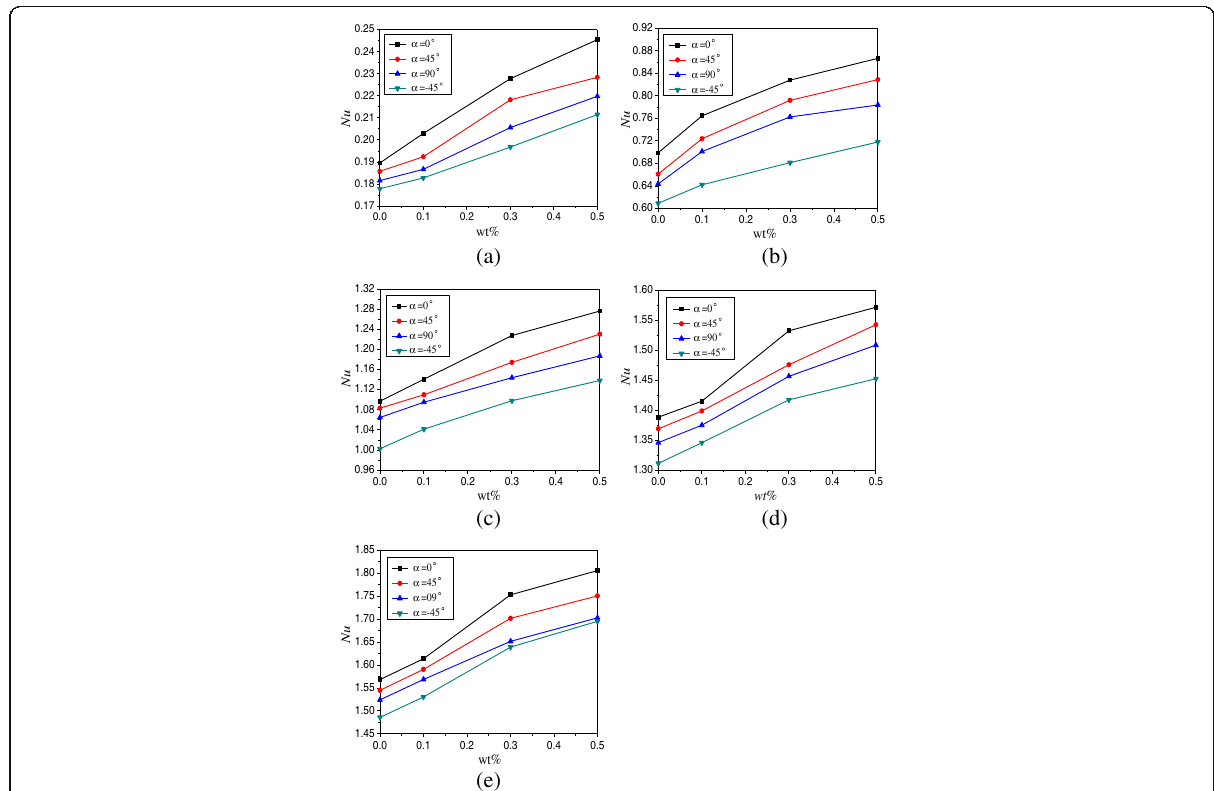
Fig. 12 Changes of Nusselt numbers with nanoparticle mass fractions ( A = 1:4). Average Nusselt numbers changes of nanofluid in the enclosure ( A = 1:4) with nanoparticle mass fractions at different heating powers. a Q = 1 W. b Q = 5 W. c Q = 10 W. d Q = 15 W. e Q = 20